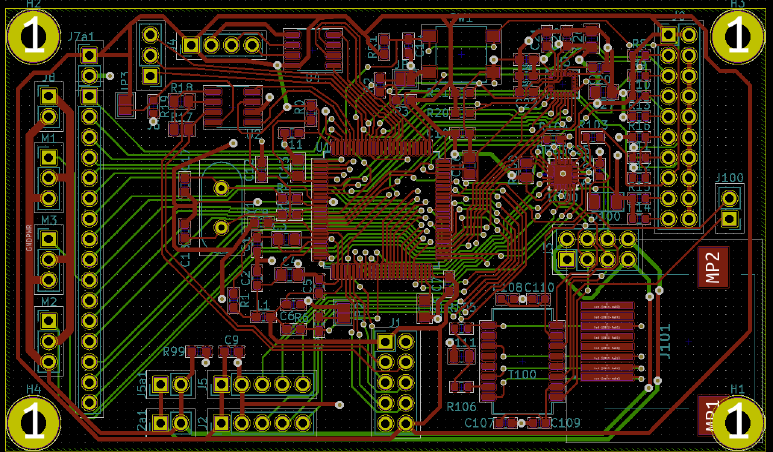
Figure 11. RoboFish Segment Board: a board designed to accommodate an STM32 F417 Microcon- troller; it serves as a networked extension to communicate with the head board and contains all of the necessary IOs for any servos or sensors and contains an LSM9DS1